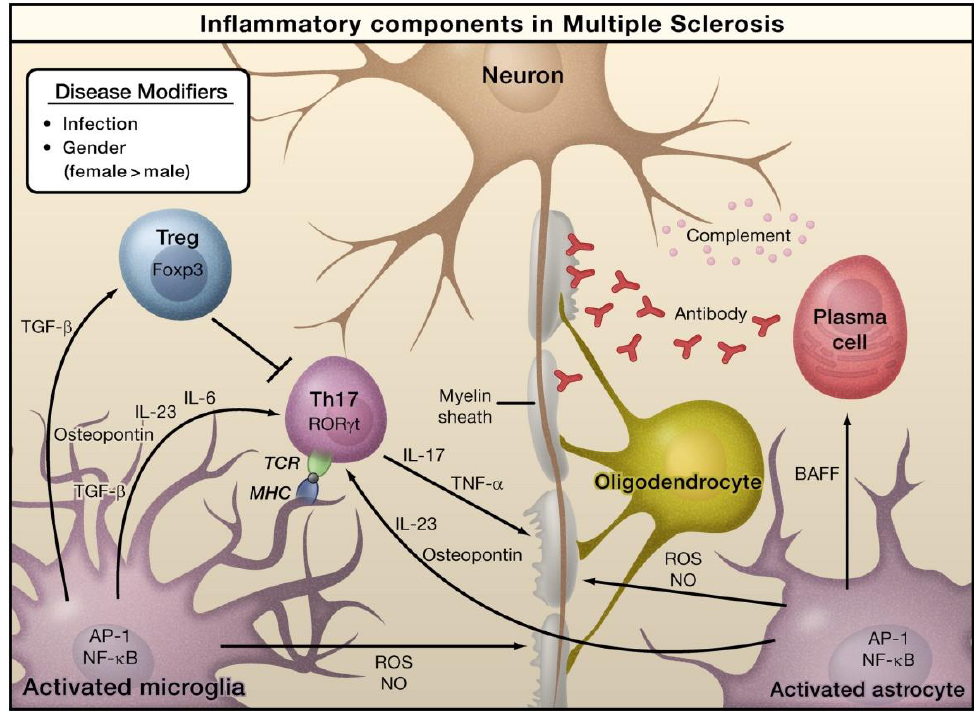
Figure 2. The role of inflammation mediators in the pathogenesis of multiple sclerosis. Reproduced with permission from Elsevier [47].